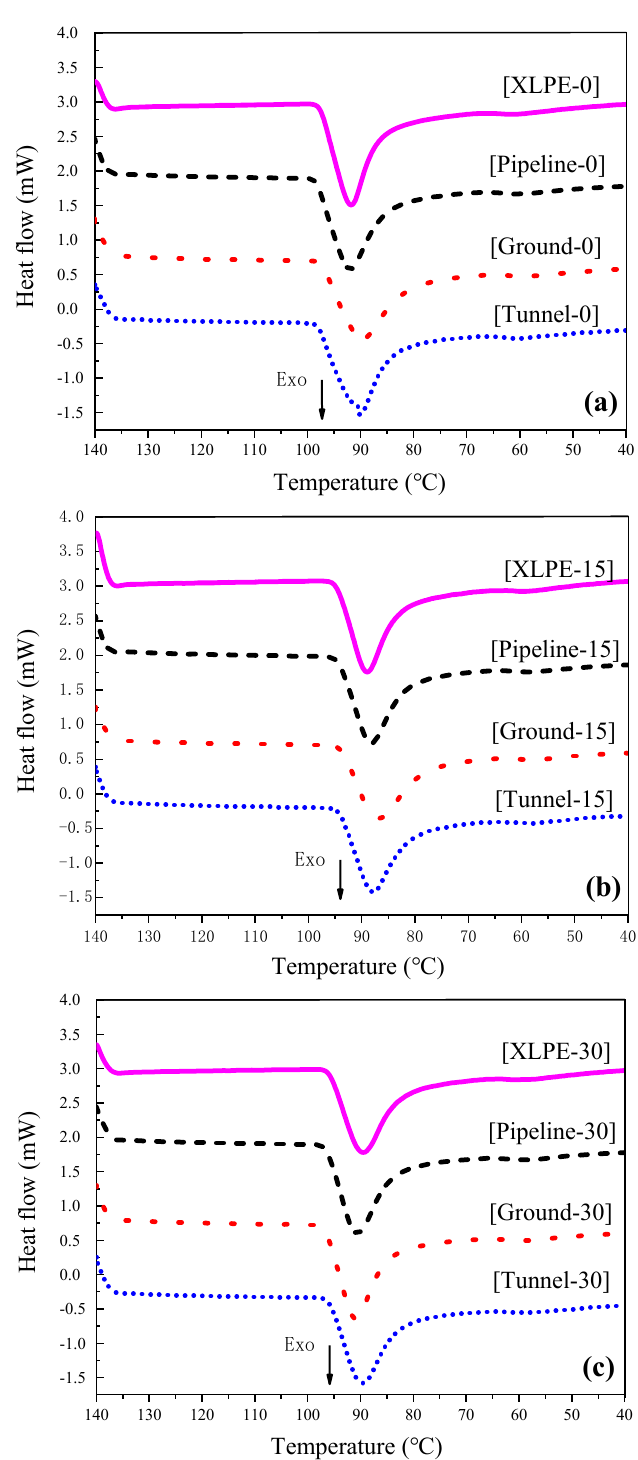
Figure 7. Heat flow as a function of measurement temperature in the first cooling of differential scanning calorimetry (DSC). (a) the spare cable; (b) the cable with service years of 15; (c) the cable with service years of 30.